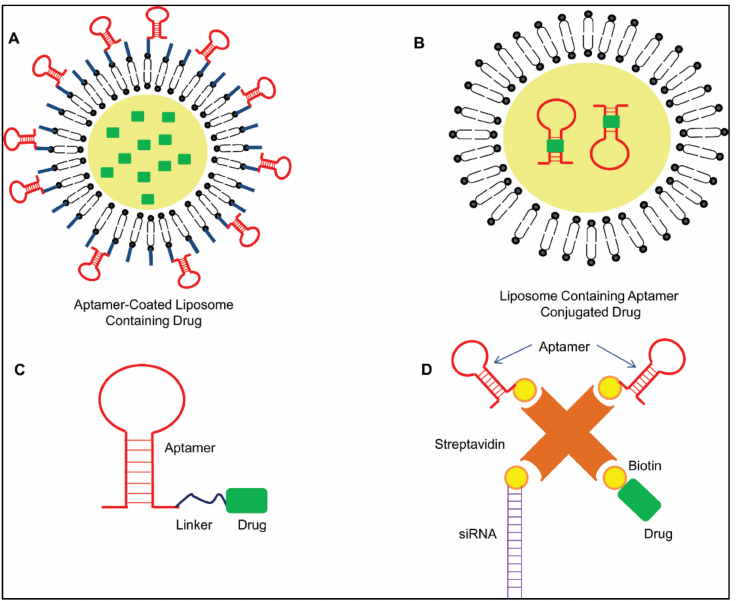
Figure 3. Schematic representation of the role of an aptamer in therapeutics. ( A ) Aptamer-coated liposome: A drug-containing liposome is conjugated with a cell surface marker-specific aptamer, which helps in targeted delivery of the drug. ( B ) Liposome containing an aptamer–drug conjugate: A drug like Doxorubicin is intercalated with an aptamer, and a drug–aptamer conjugate is coated by a cationic liposome, which enhances the delivery of the drug. ( C ) Linker-joined aptamer–drug conjugate: Short linkers are used to join the drug with an aptamer by click reaction. ( D ) Aptamer– siRNA–drug chimera: Streptavidin has four binding domains where the biotinylated aptamer, drug and siRNA bind. The aptamer helps in the targeted delivery of siRNA and the drug, whereas siRNA and the drug help in gene silencing and therapeutics at the desired